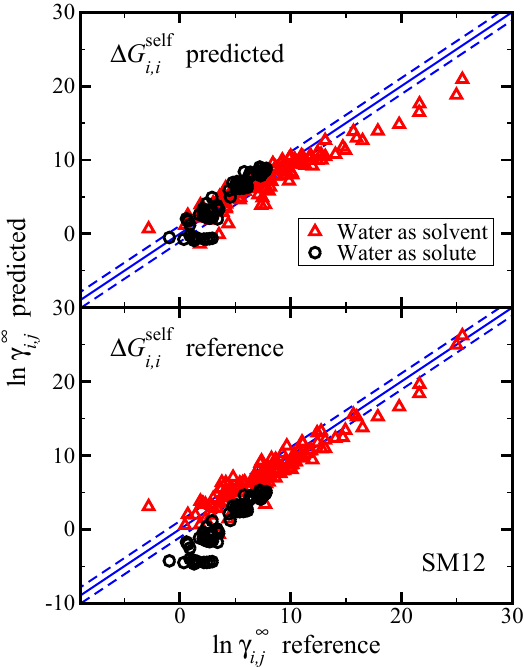
Figure 8. Parity plot of the predicted versus reference values of ln γ ∞ using the SM12 universal solvent i , j model for the case where water was the solvent and water was the solute, as indicated. The blue lines corresponds to the y = x line, and the dashed blue lines correspond to ± 1.1 and are drawn as a reference. The reference values are from “Yaws’ Handbook of Properties for Aqueous Systems” [56]. In the top pane we present results when ∆ G self was predicted using the SM12 universal solvent model. i , i In the bottom pane we present results when ∆ G self was computed using reference vapor pressure i , i